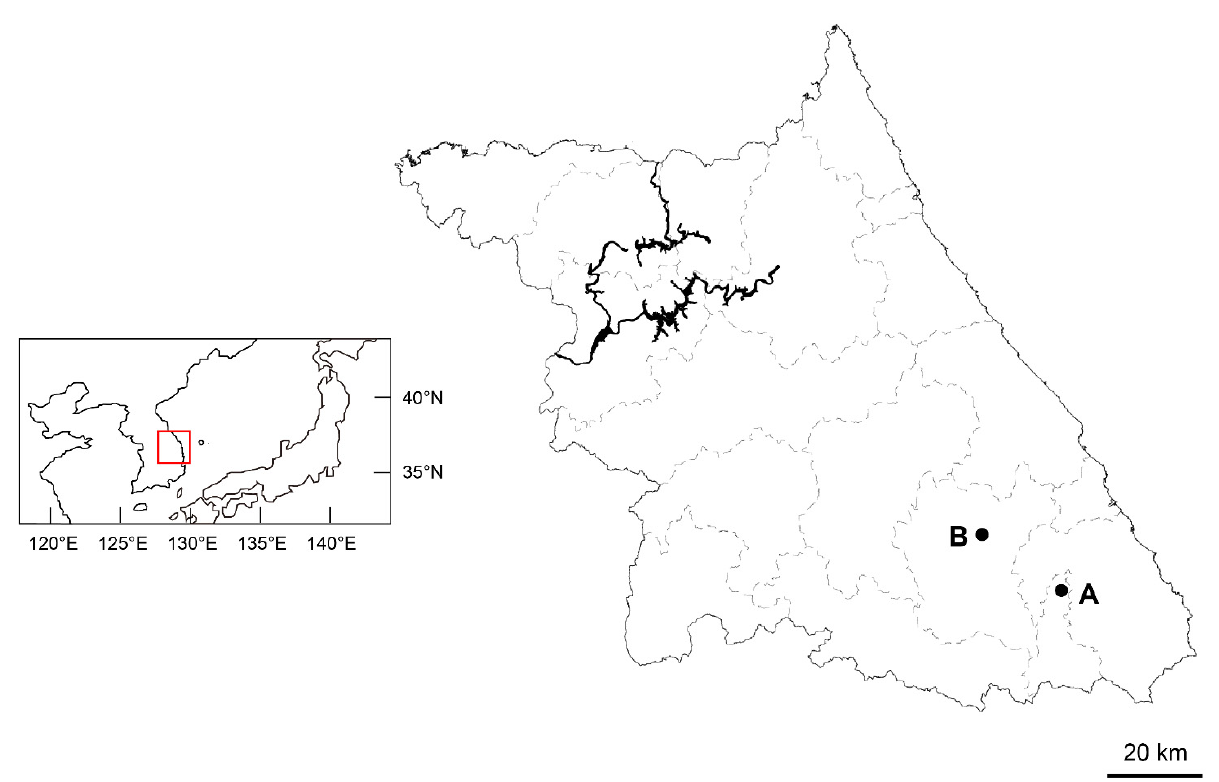
Figure 6. Collection sites for Asplenium sp. A: Taebaek-si. B: Jeongsun-gun. Table 2. List of plant materials used for DNA analysis in this study.